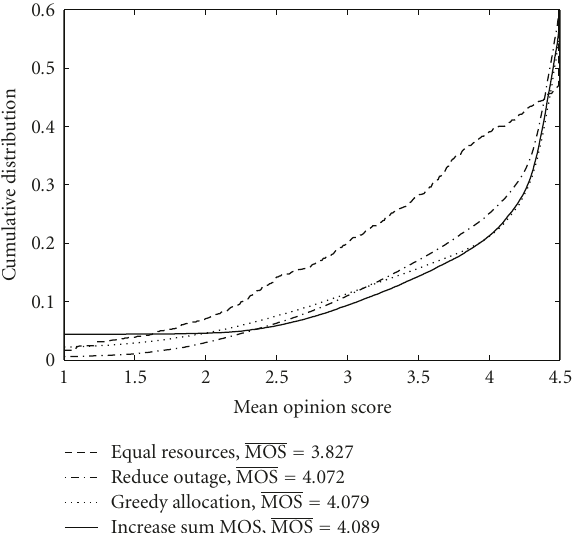
Figure 9: CDF of the perceived quality for video streaming with nonconcave application characteristic.